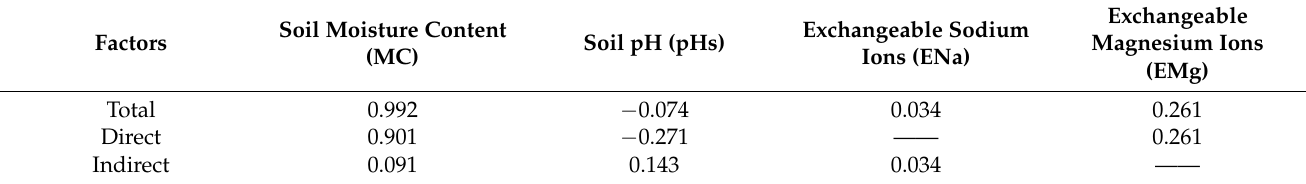
Table 1. The direct, indirect, and total effects of soil moisture content, pH, and exchangeable metal ions on soil adhesion to minerals based on structural equation